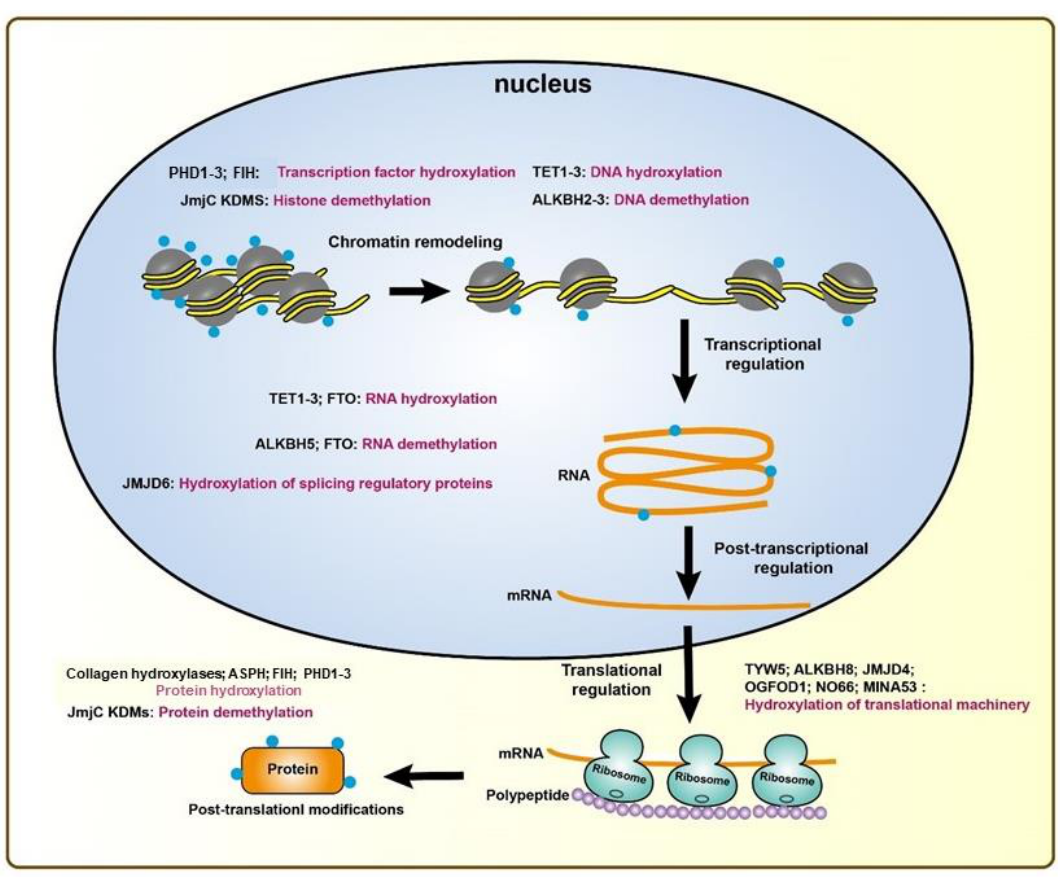
Figure 2. 2-OG-dependent oxygenases involved in protein synthesis. 2-OG-dependent oxygenases catalyze hydroxylation and demethylation reactions that regulate transcriptional, post-transcriptional, translational, and post-translational processes [159]. ALKBH , alkylated DNA repair protein alkB homolog; TET1–3 , ten-eleven translocation 1–3; FTO , fat mass- and obesity-associated protein; TYW5 , tRNA wybutosine-synthesizing protein 5; KDM , histone lysine demethylase.